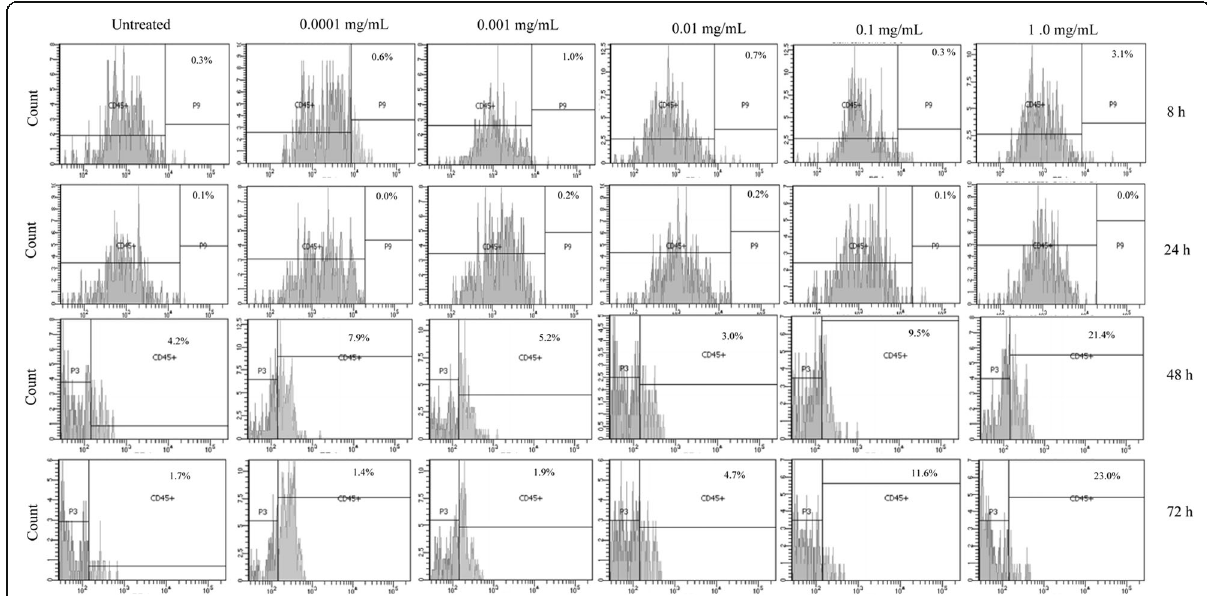
Fig. 5 In vitro CD45 expression stimulated by ‘ StemForte Plus® ’ by Flow Cytometry Method